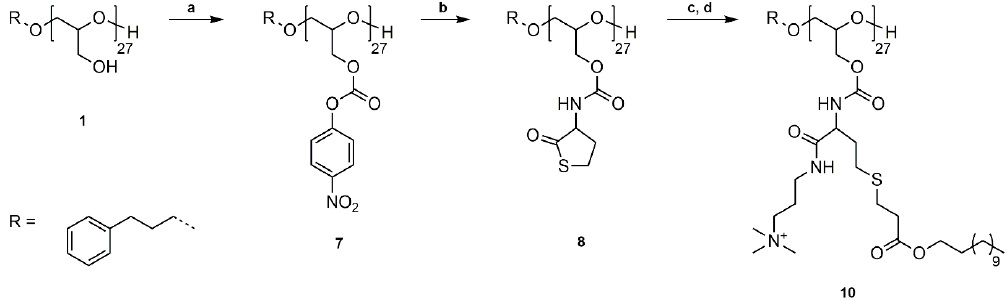
Figure 3. 1 H NMR spectra of P(G DDAc, q ) 27 ( 10 ) measured in CDCl 3 ( a ) and P(G TMAPA14 - co -G DDADDAc13 ) ( 12 ) measured in CDCl 3 /acetone (6:4) ( b